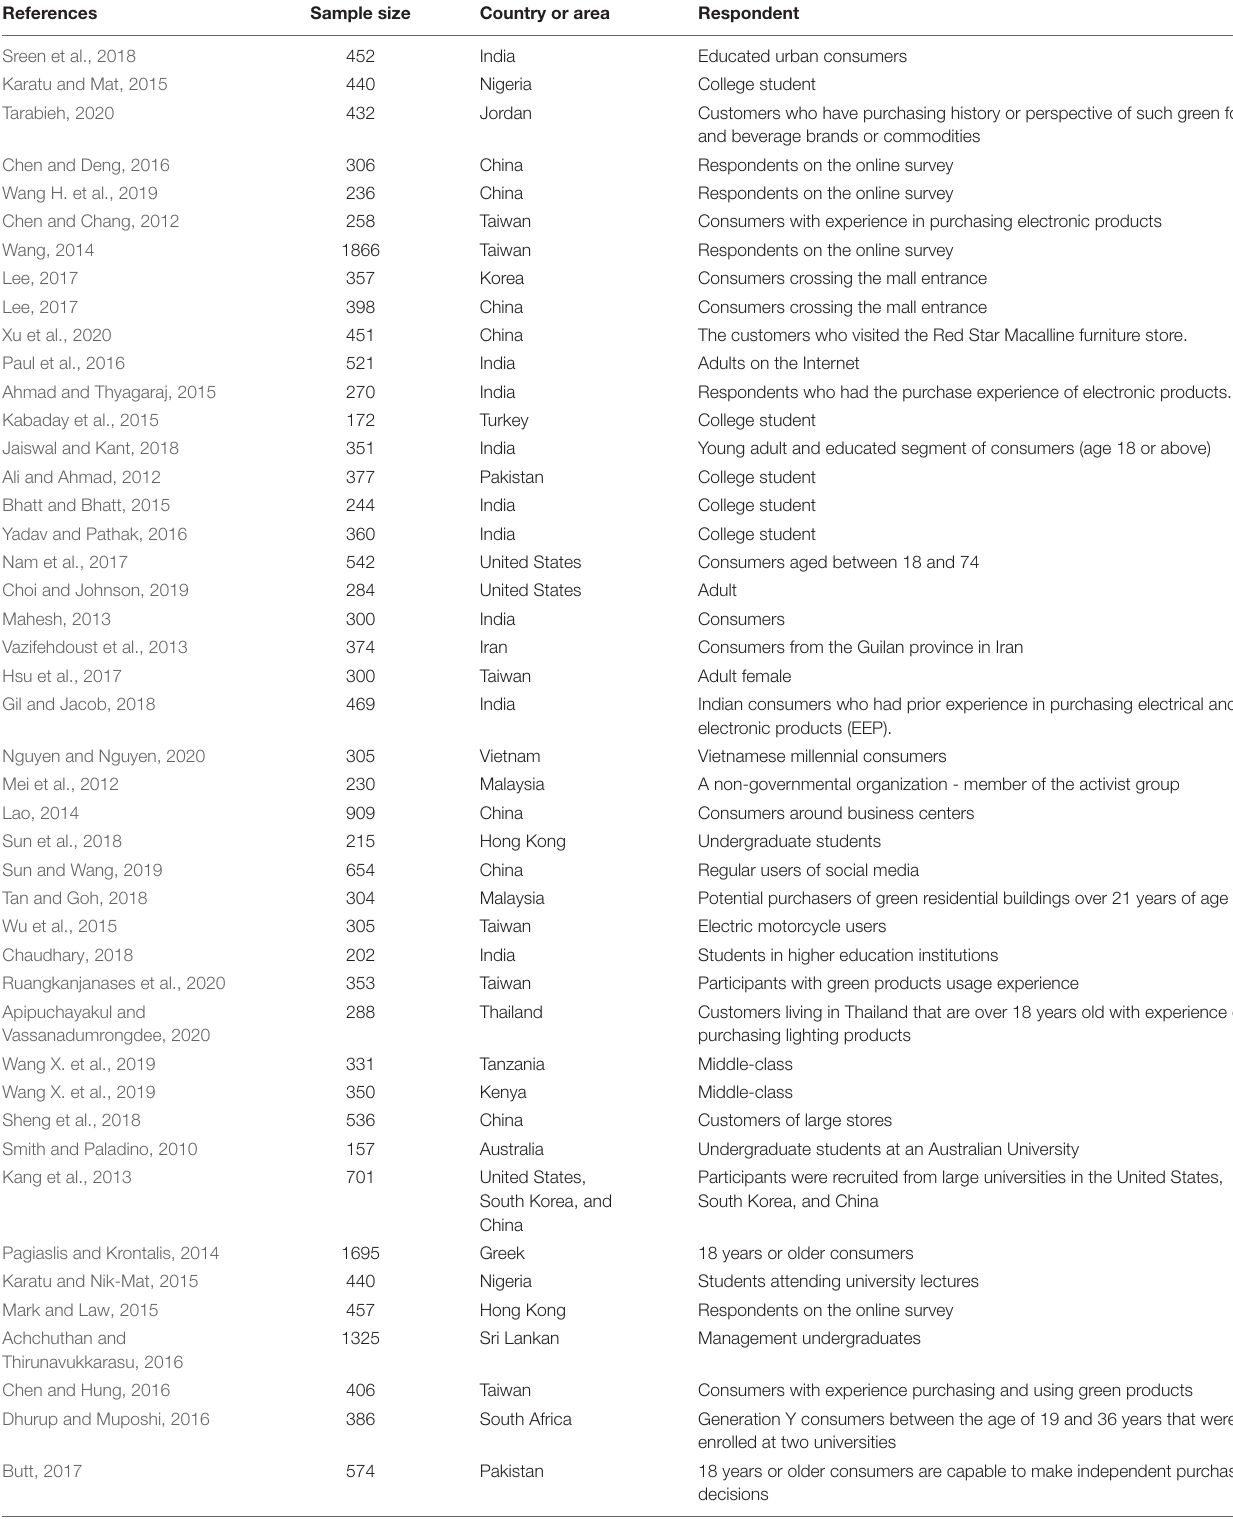
TABLE 1 | Studies selected for